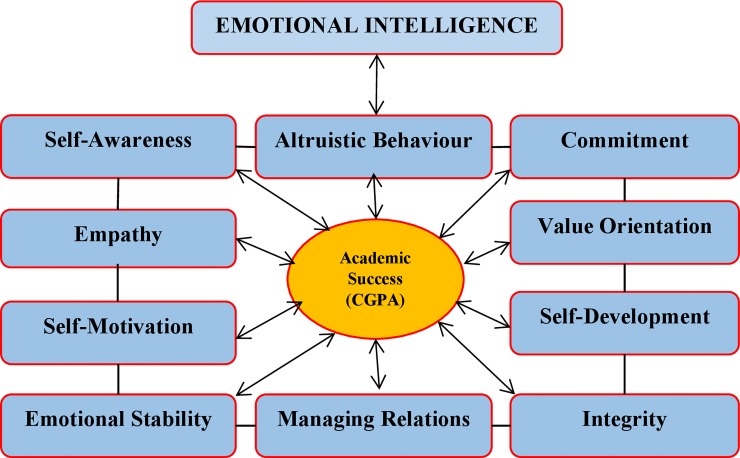
Conceptual framework of the Study.The Conceptual Framework shows the correlation model between subdimensions of emotional intelligence and academic success in terms of Cumulative Grade Point Average (CGPA) among undergraduate students.